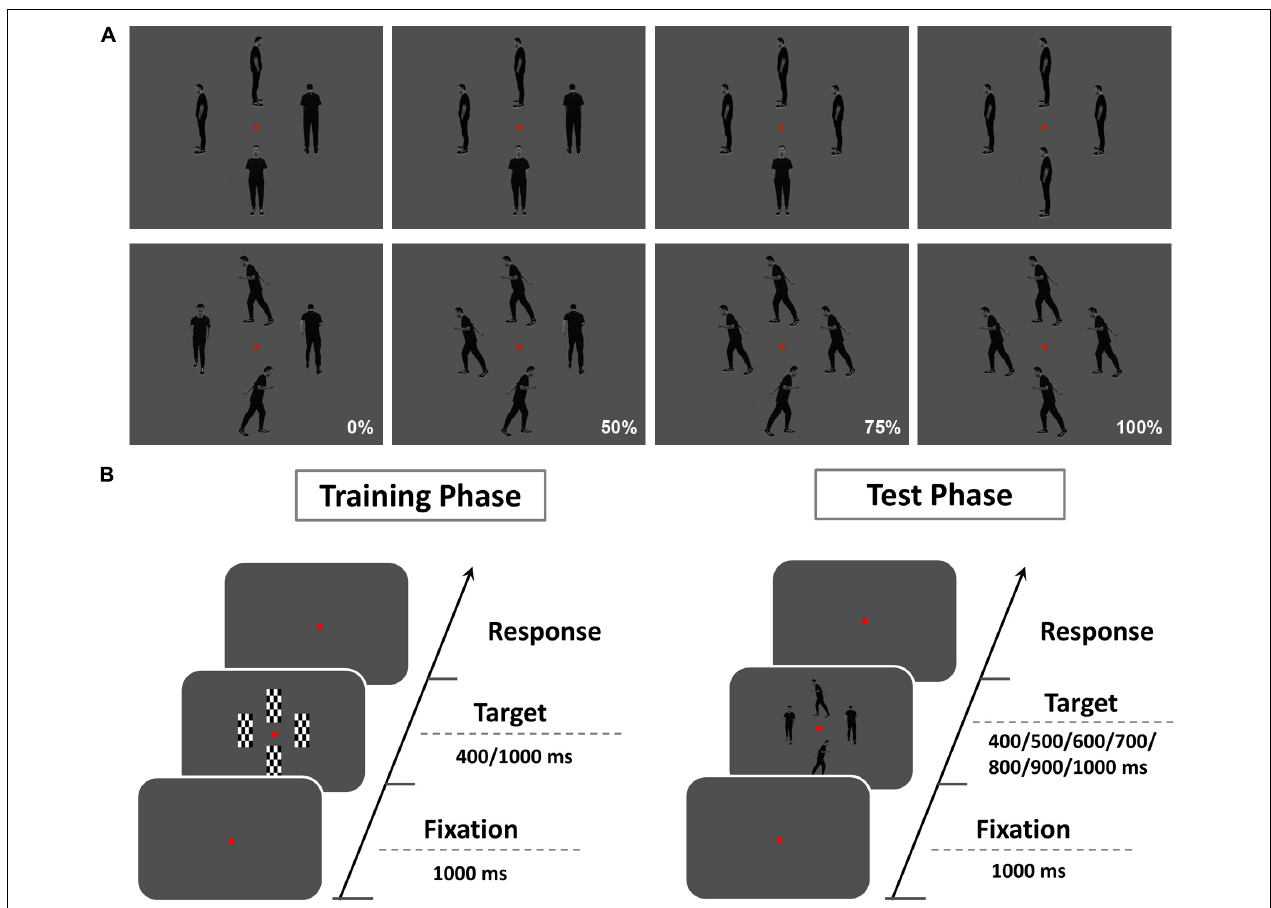
FIGURE 1 | (A) The illustration for stimuli used in the experiment. Two types of gray-scale pictures were used as test stimuli: implied motion (IM; top row), non–implied motion (non-IM; bottom row). IM stimuli consisted of three sets of four images of a single person surrounding a central fixation point at a distance of two degrees. In each image, the human agent was running left, right, toward, or away from the viewer. The non-IM stimuli also consisted of three similar sets of images, but in these images, the human agent was shown in a standing position, leaning left, right, toward, or away from the viewer. Coherence was operationalized as the percentage of images facing toward or moving in a single horizontal direction and composed of four levels (0, 50, 75, and 100%). (B) Schematic diagram showing the procedure of the present study. The whole experiment was divided into two sessions: an initial training phase and a follow-up test phase.